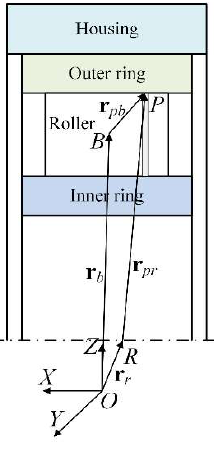
Figure 1. Interaction between a roller and outer ring.